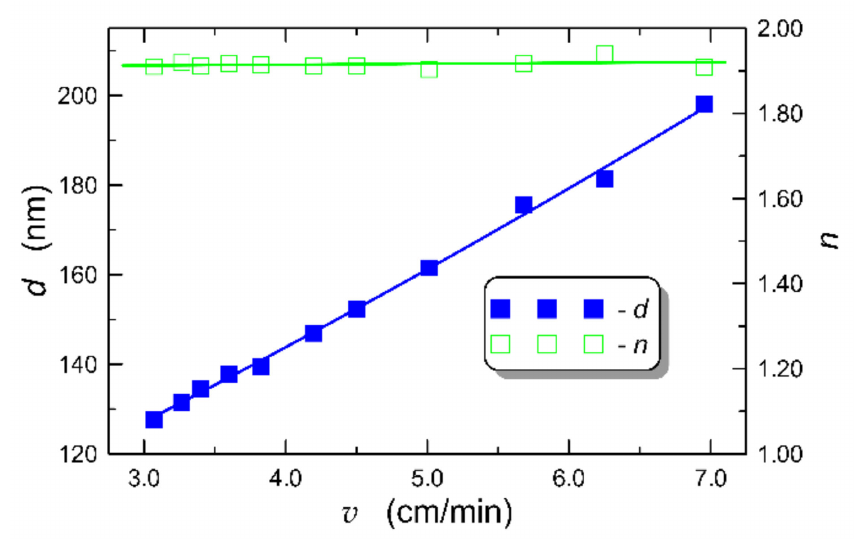
Figure 10. Experimental characteristics showing the dependence of the thickness and refractive index with respect to the substrate withdrawal speed from sol. Description of symbols: d —thickness, n —refractive index, v —withdrawal speed.